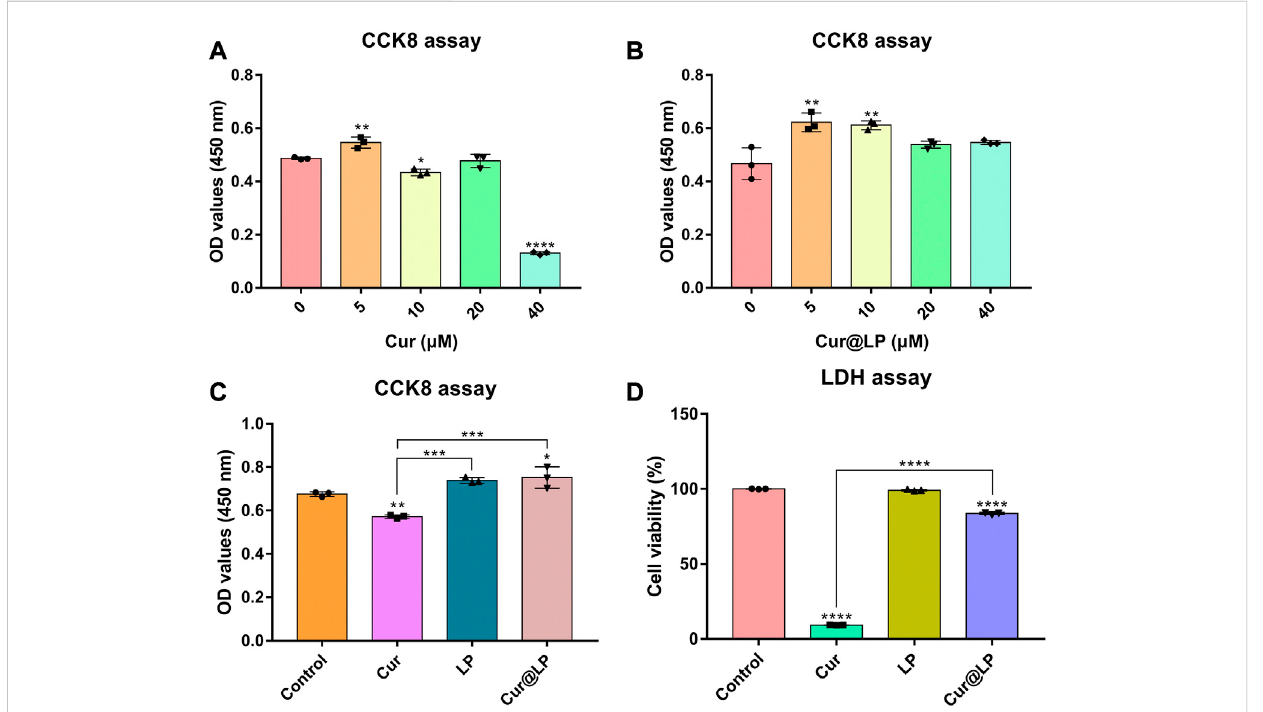
FIGURE 4 (A) CellviabilityofMC3T3-E1followingcultivationwithdifferentconcentrationsofcurcumin. (B)